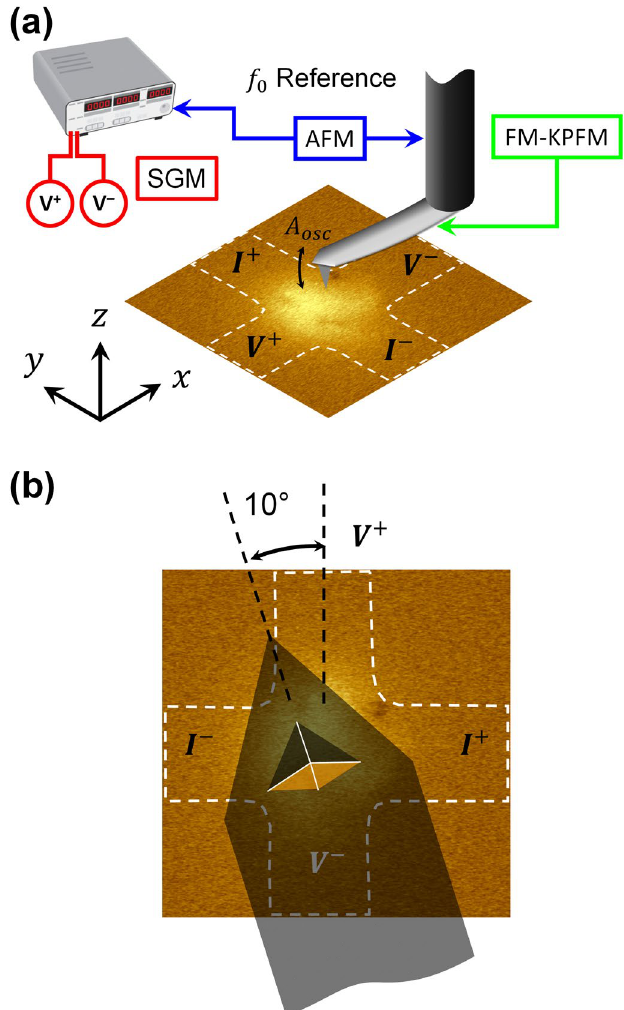
Figure 5. Experimental mSGM setup. ( a ) Schematic of the single-pass mSGM mode with FM-KPFM feedback to eliminate the undesirable electrostatic interaction between the MFM probe and Hall sensor. ( b ) Schematic representation showing the 10° in-plane rotation of the cantilever with respect to the vertical arm of the Hall